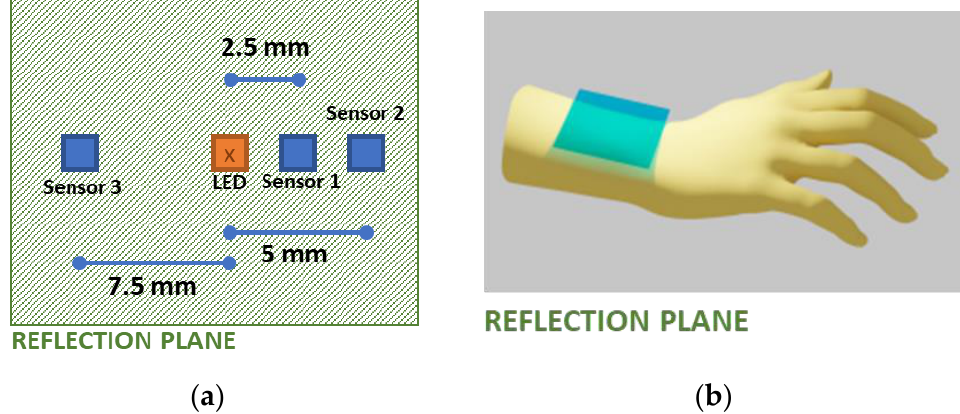
Figure 9. LED-PD arrangements for the wrist model. ( a ) LED-PD arrangement in the reflection plane, ( b ) physical location of the reflection plane for the wrist model.